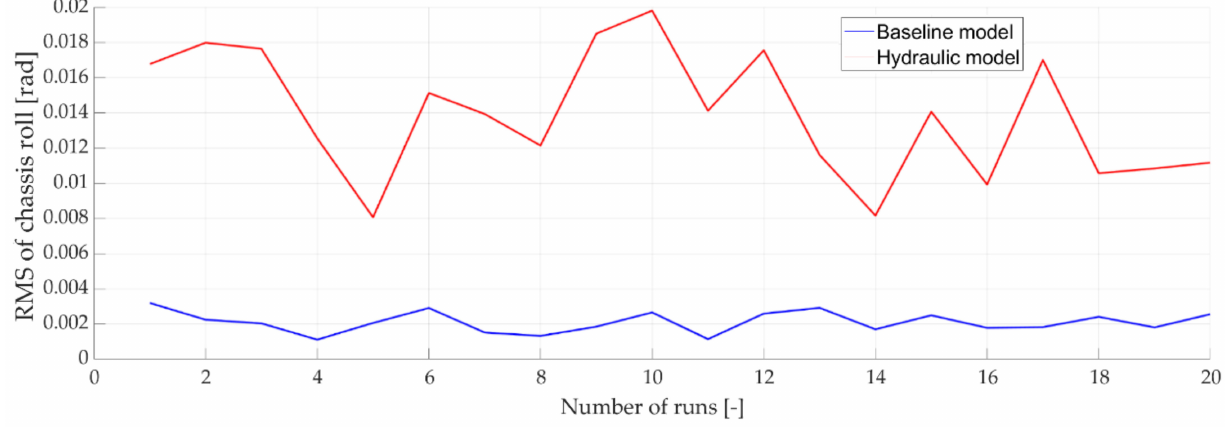
Figure 17. Chassis roll root means square for a realistic road profile.